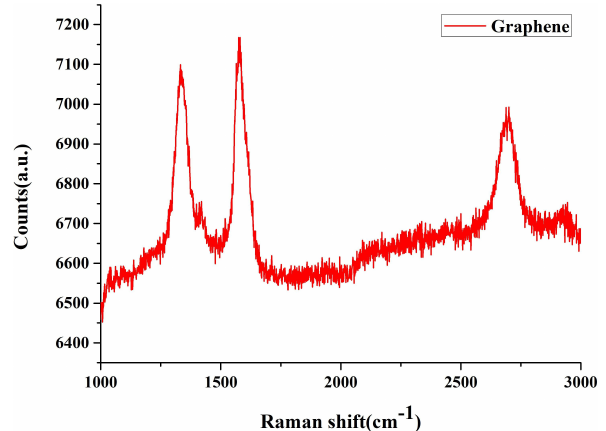
Figure 6: Zeta potential of different T on :T off Figure 7: Zeta potential of 10:10